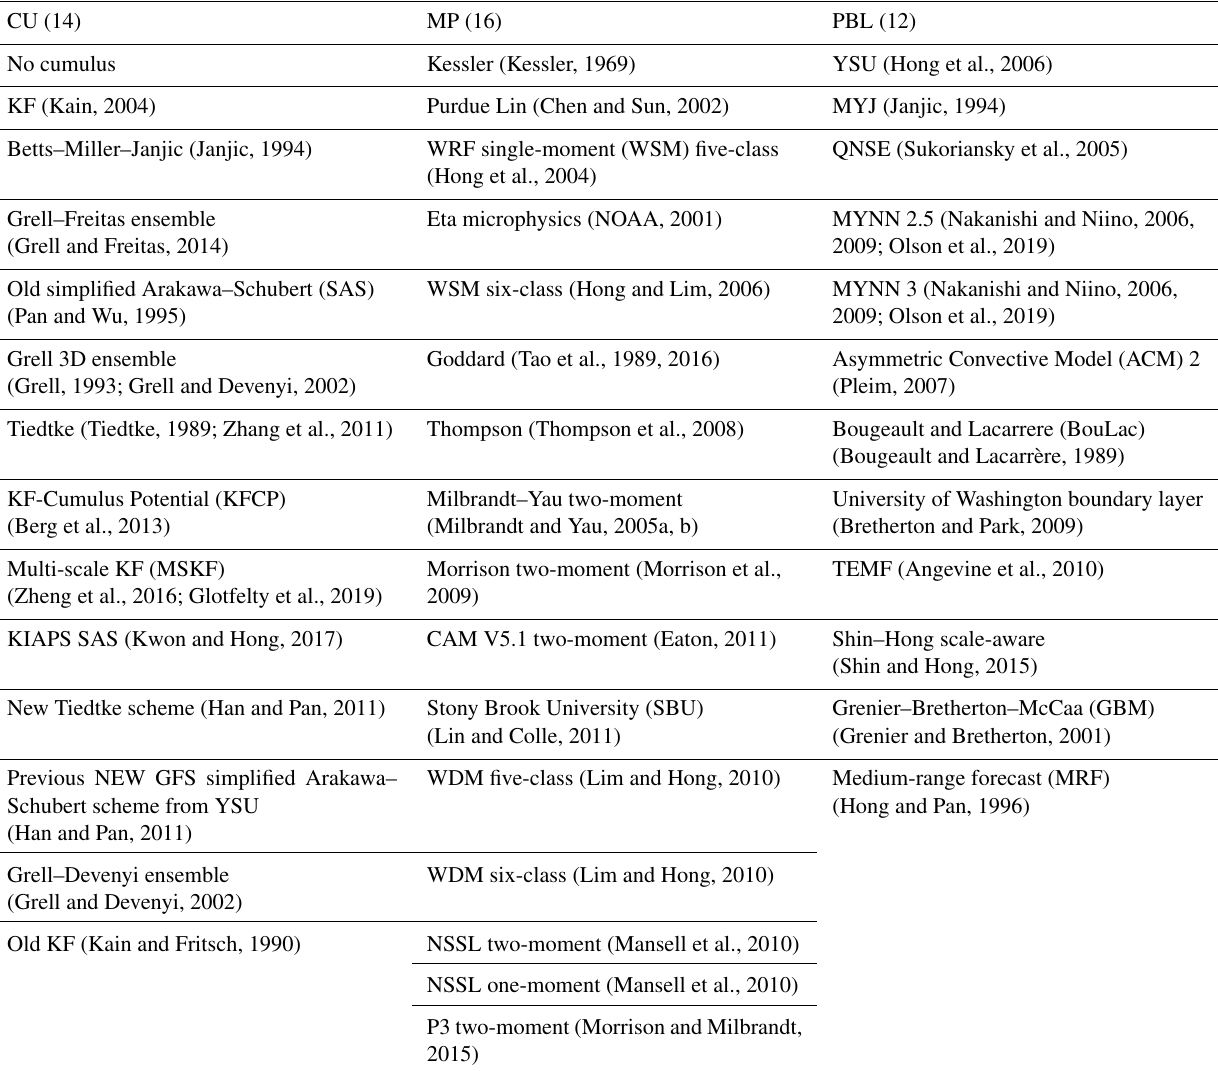
Table 2. Summary of CU, MP, and PBL physics schemes used in the µ-GA–WRF interface system for the optimization.